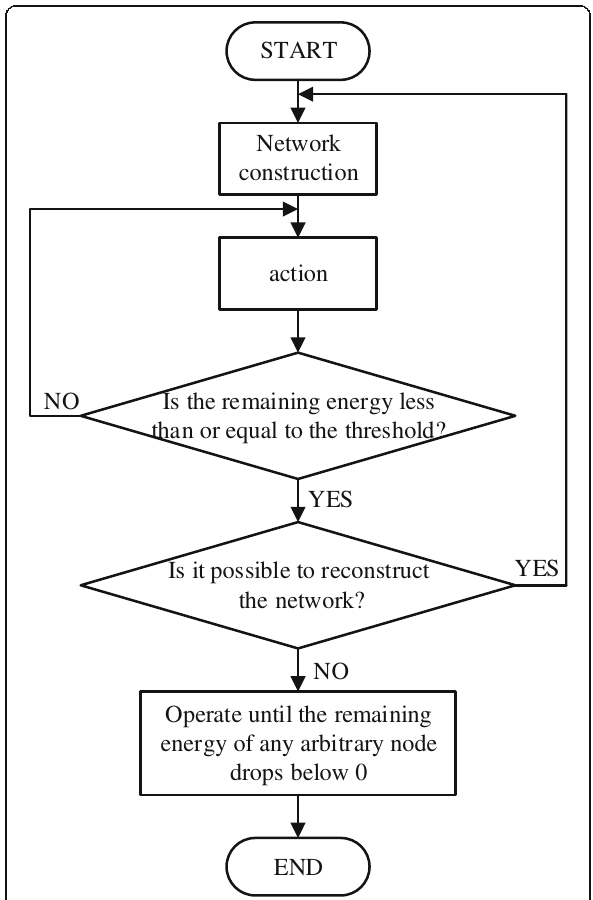
Fig. 11 Flow chart of reconstruction method with fixed threshold.